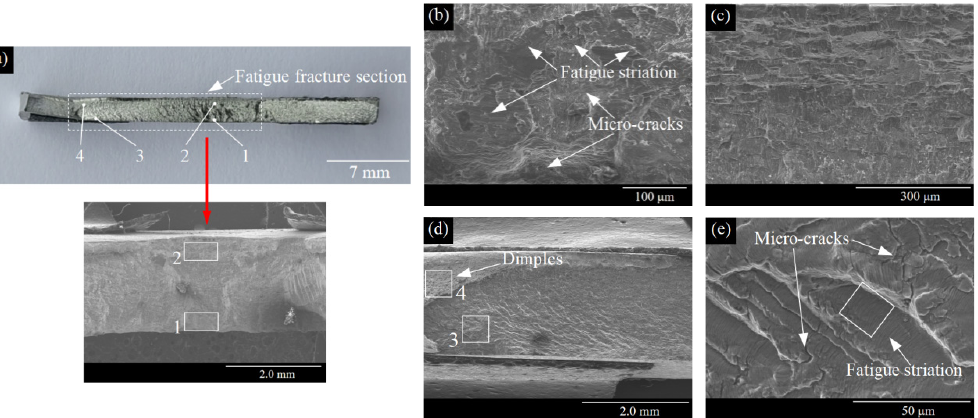
Figure 15. Fatigue fracture micro-morphology of AA5052 sheet in the AS joint. ( a ) Macroscopic morphology of fatigue fracture; ( b ) micro-morphology of area 1; ( c ) micro-morphology of area 2; ( d ) micro-morphology of areas 3 and 4; ( e ) magnified morphology of area 3.